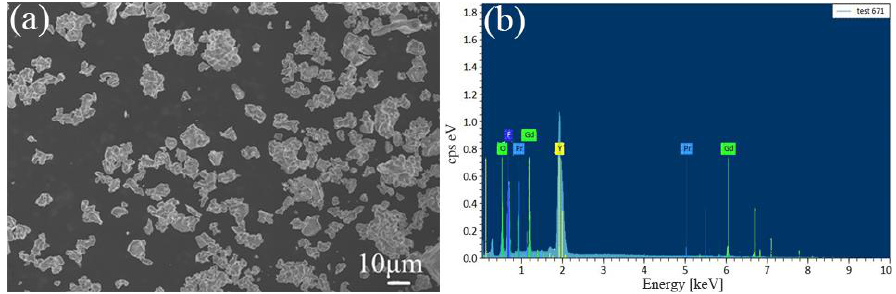
Figure 3. ( a ) SEM and ( b ) EDS images of Y 7 O 6 F 9 :1.4%Pr 3+ , 10%Gd 3+ phosphor.